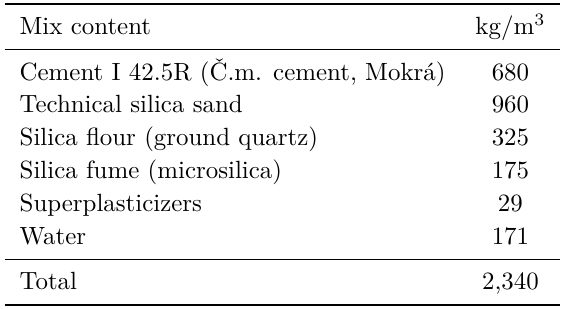
Table 1. HPC mix